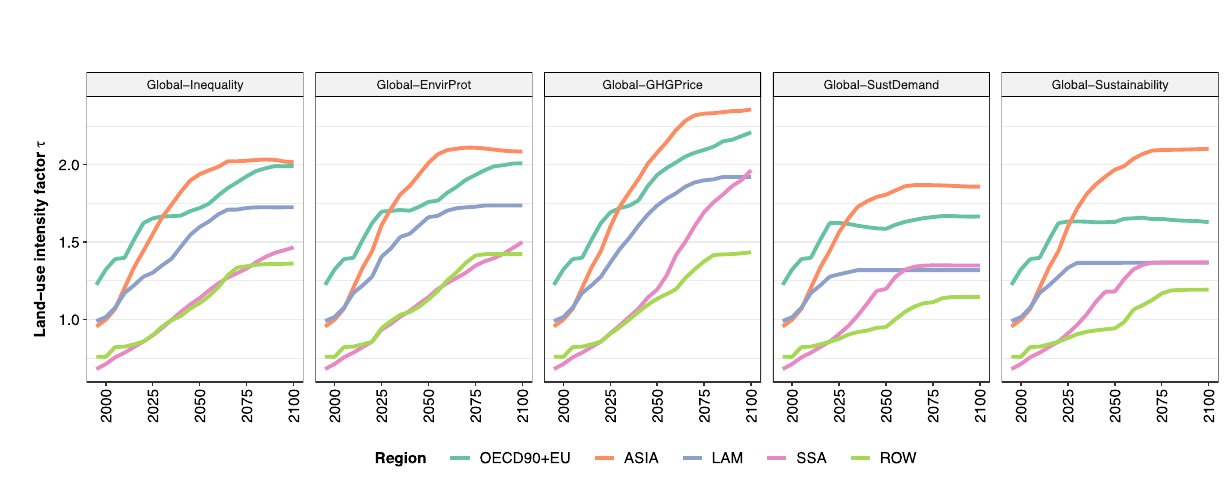
Fig. 5 | Land-use intensity factor τ . Data are shown at regional level for fi ve scenarios. The τ factor re fl ects the degree of crop yield ampli fi cation caused by human activities. A duplication of τ implies a doubling of crop yields under fi xed environmental conditions. See Fig. S10 for validation